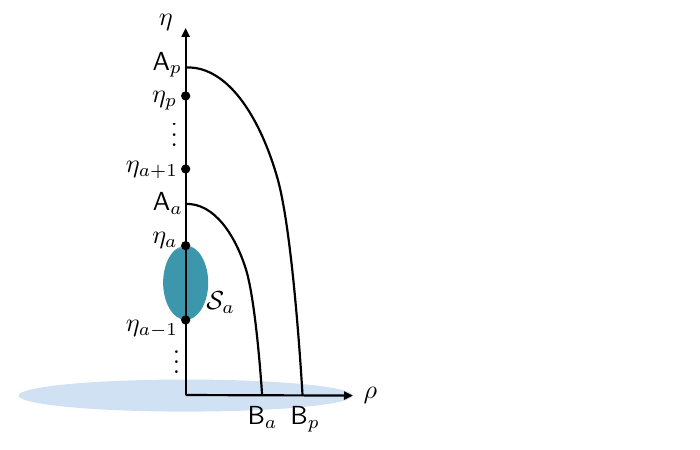
Figure 2 . A generic pro(cid:12)le of monopoles. The arcs A denotes the 2-cycle , which is part of the 4-cycle S a